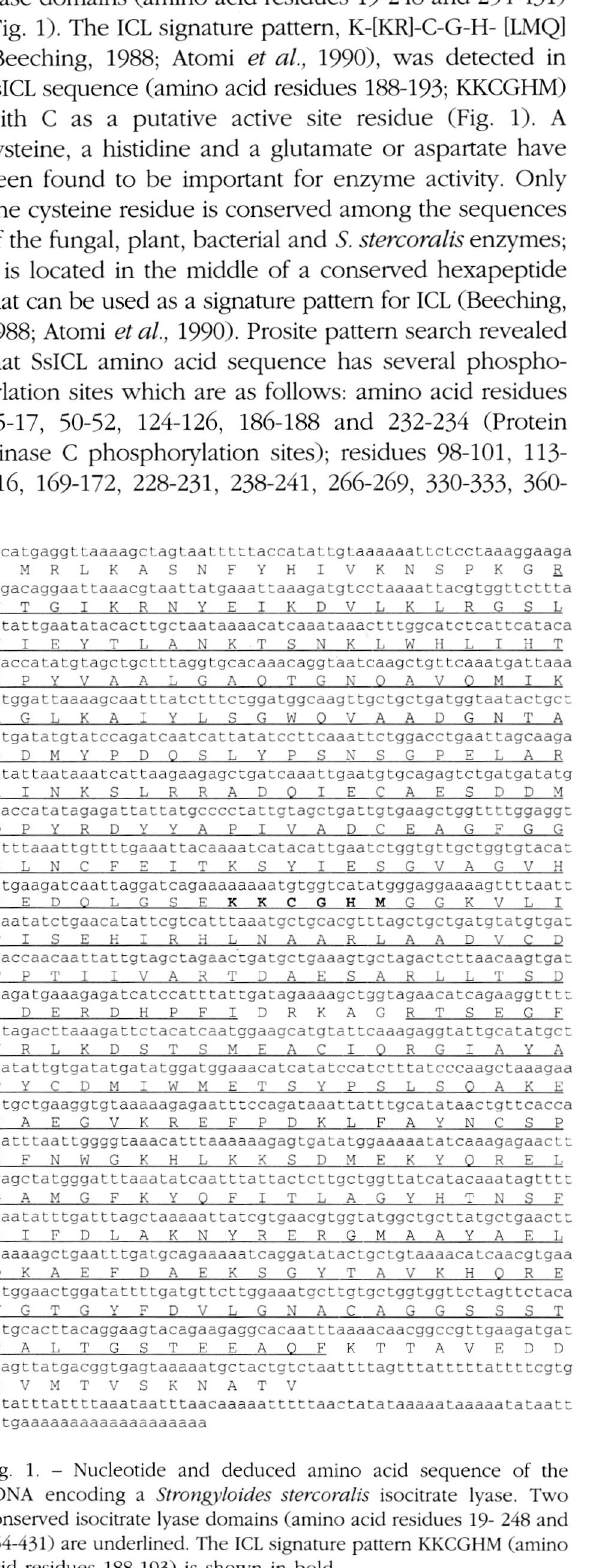
Fig. 1. - Nucleotide and deduced amino acid sequence of the cDNA encoding a Strongyloides stercoralis isocitrate lyase. Two conserved isocitrate lyase domains (amino acid residues 19- 248 and 254-431) are underlined. The ICL signature pattern KKCGHM (amino acid residues 188-193) is shown in